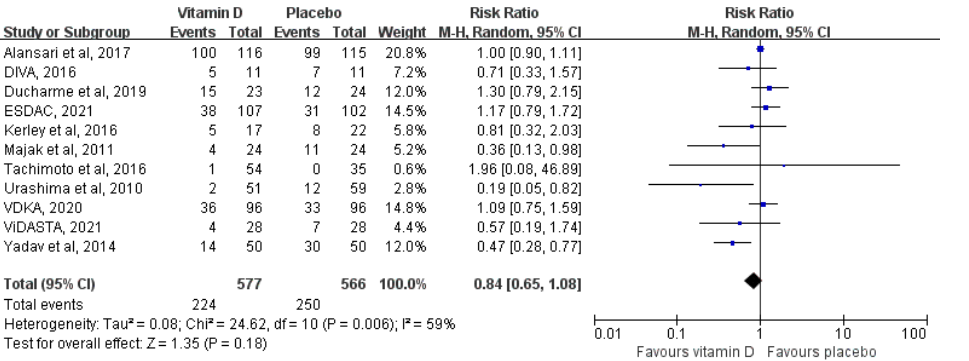
Figure 2. Meta-analysis of the number of children with one or more asthma